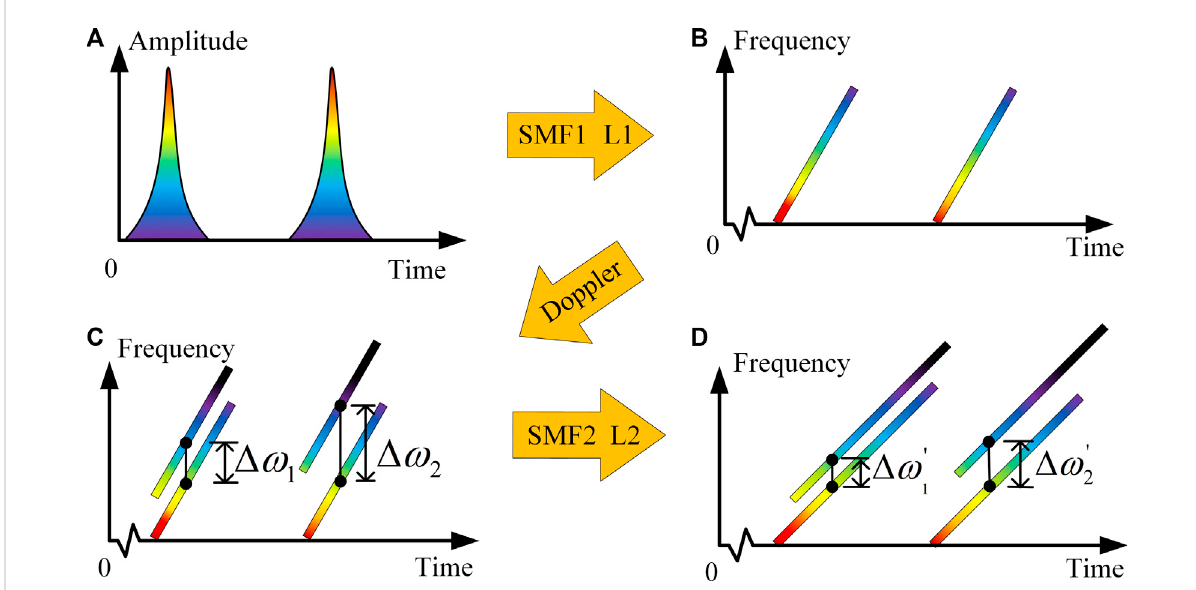
FIGURE 1 Schematicdiagram oftime-stretched principle. SMF1 L 1 andSMF2 L 2 :thelength ofthe fi rst-ordersinglemode fi beris L 1 ,andthesecond-order single mode fi ber is L 2 , Δ ω 1 , Δ ω 2 , Δ ω 1 ′ and Δ ω 1 ′ : the difference between the signal and the reference pulses. After a single-mode fi ber of fi rst order length L 1 , (A) the femtosecond laser pulses are dispersed into (B) nanosecond linearly chirped pulses. (C) The velocity information is encoded onto multiple chirped pulses using the optical Doppler effect. The frequency difference between the signal light and the reference light is Δ ω . After passing through a single-mode fi ber of second order length L 2 , (D) the chirped pulses with encoded velocity signals move with a velocity lagging behind the reference pulse, and the beat frequency signal is downscaled to Δ ω ′ (cid:1) Δ ω L 1 / ( L 1 + L 2 )